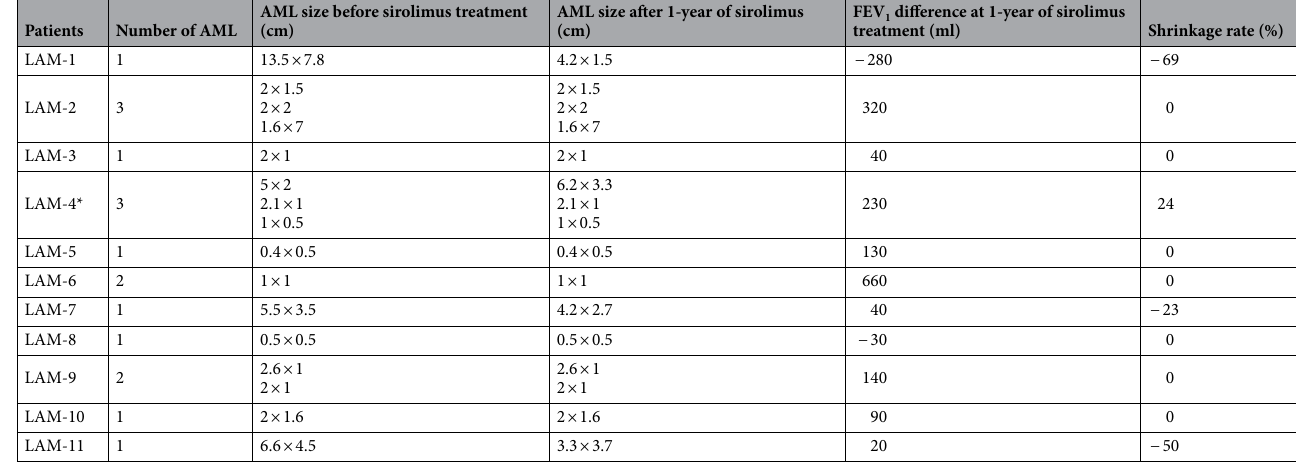
Table 4. Angiomyolipomas’ shrinkage rate at 1 year. AML angiomyolipoma.